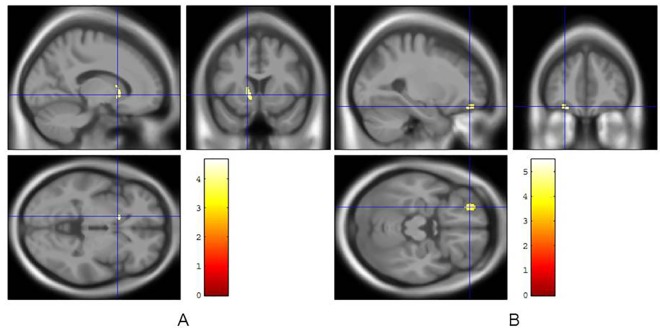
SPM map.Significant negative correlations between cerebral VMAT2 density and CSF Aβ1–42 (A) and p-tau (B) levels normalized scores with adjustment for age and sex of the PD patients. Significant clusters are displayed with slices of MRI templates in axial, coronal and sagittal orientations. p-value < 0.001 at the voxel level for clusters>50 contiguous voxels (corrected for cluster volume).